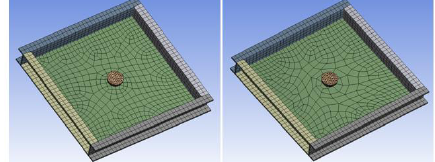
Fig.11 Tensile test Fig.12 Steel specimen Fig.13 Force-elongation diagram-steel